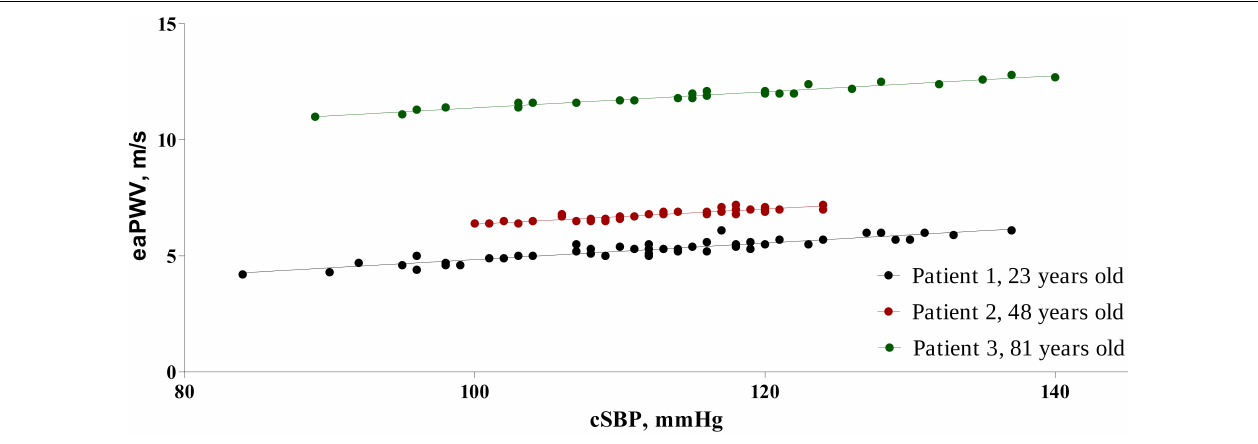
FIGURE 1 | Correlation between central blood pressure and pulse wave velocity in individual patients in three different age ranges; A < 25 years; B- 40–50 years; C > 75